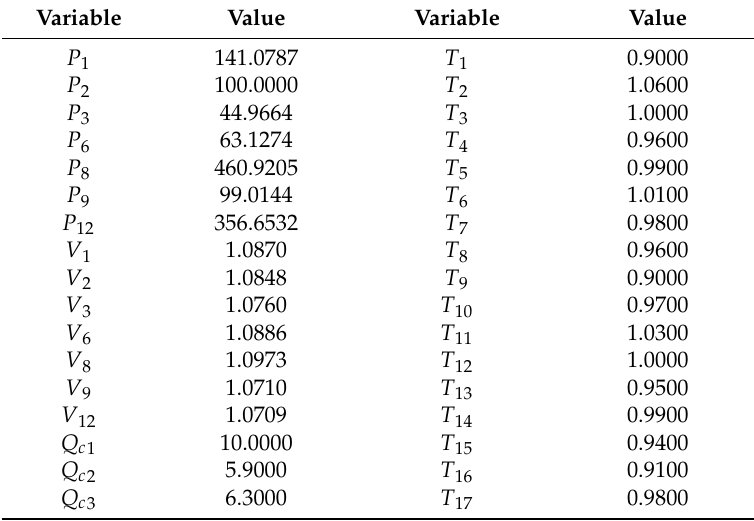
Table A2. Optimal solutions obtained by the proposed method for the IEEE-57 bus power